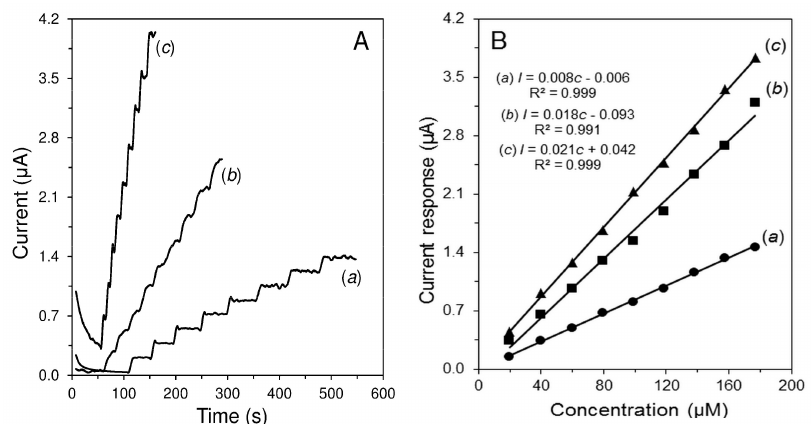
Figure 1. Comparison of ( A ): amperometric records and ( B ): calibration curves, obtained at bare GCE ( a ), GCE / MWCNTs / chitosan ( b ), and GCE / MWCNTs / Nafion ® ( c ) to additions of 20 µ L H 2 O 2 (0.1 M). All measurements were performed in 0.1 M phosphate bu ff er (PB) of pH 7.0 at potential + 0.8 V and speed of stirring 400 rpm.